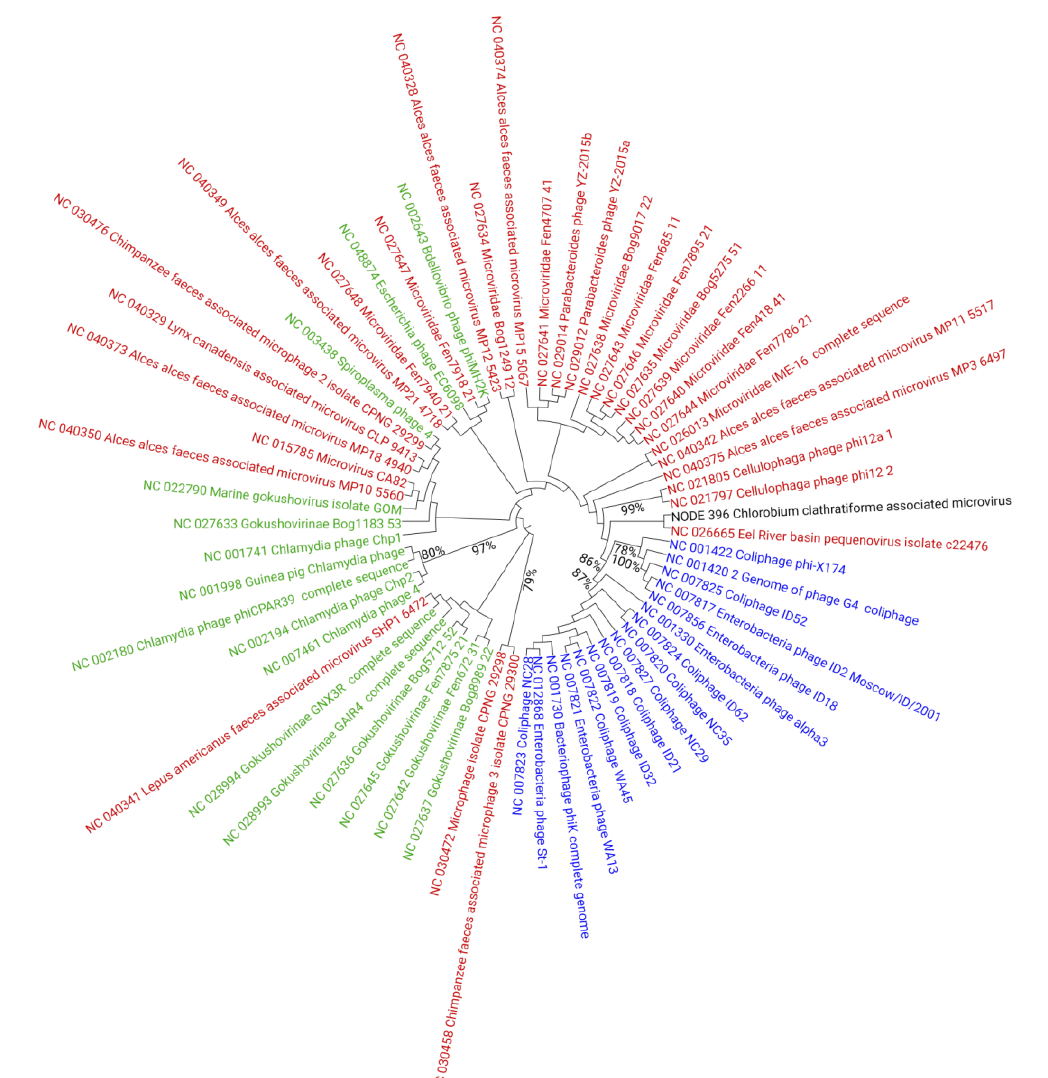
Figure 3. Phylogenetic tree reconstruction of Microviridae family bacteriophages (RefSeq DB; accessed on March 2021) and representation of C . clathratiforme SAGs-associated Microviridae genome (NODE_396). Members of Bullavirinae are marked in blue, members of Gokushovirinae are marked in green and unclassified microviruses are marked in red. The C. clathratiforme SAGs-associated Microviridae phage genome (NODE_396) is shown in black. The tree was calculated using a neighbor joining algorithm of the conserved sites in the genomes, with the bootstrap values higher than 75% given at the nodes.